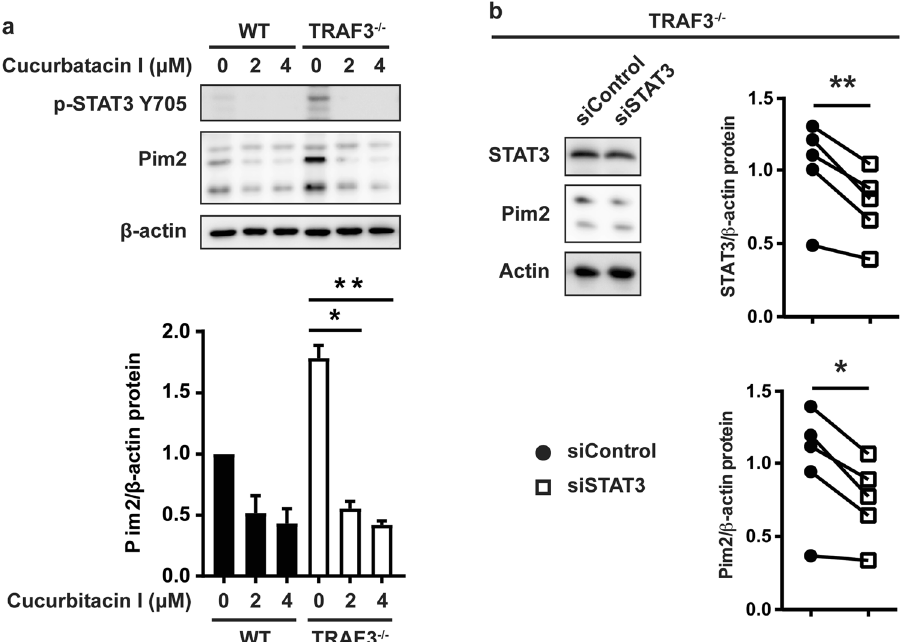
Figure 4. Impact of STAT3 inhibition in TRAF3-deficient B cells. ( a ) TRAF3 − / − B cells were treated with the indicated concentrations of the STAT3 inhibitor Cucurbatacin I for 16 hrs. Expression of p-STAT3 Y705 and Pim2 was analyzed by WB from WCLs. Blot is representative of 3 independent experiments. Pim2/ β -actin loading control was normalized to the WT value. Graph shows mean values ± SEM shown (N = 3). An unpaired t test was used to evaluate differences for statistical significance ( * p < 0.05, ** p < 0.01). ( b ) TRAF3 − / − B cells were transfected with control or siRNA targeting STAT3. 24 hrs later, Pim2 and STAT3 expression in WCLs were analyzed by WB. Graphs depict STAT3 or Pim2 expression/ β -actin loading control and normalized to the average of the siRNA control. A paired t test was used to evaluate differences for statistical significance ( * p < 0.05, ** p < 0.01, N =